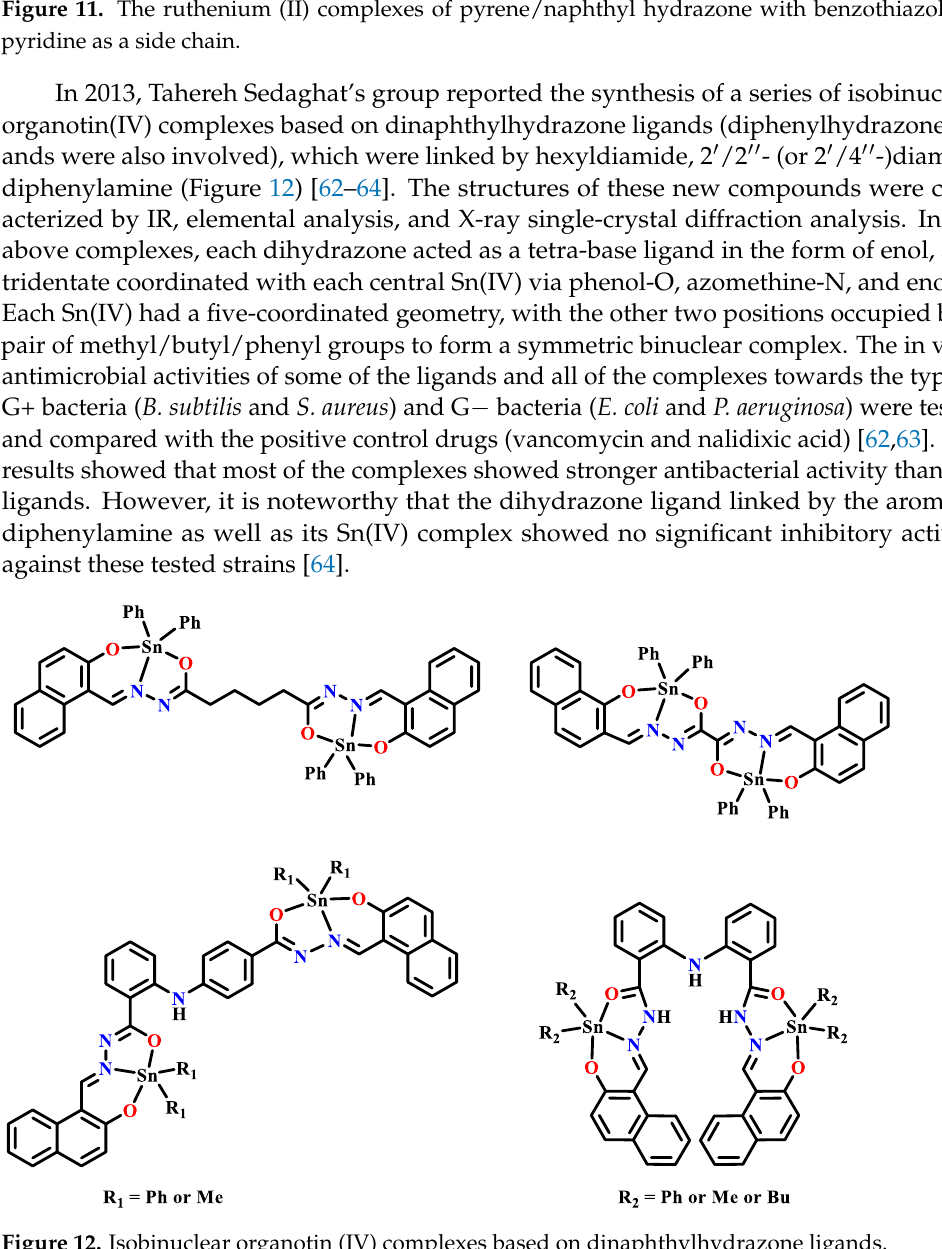
Figure 11. The ruthenium (II) complexes of pyrene/naphthyl hydrazone with benzothiazole or pyridine as a side chain.